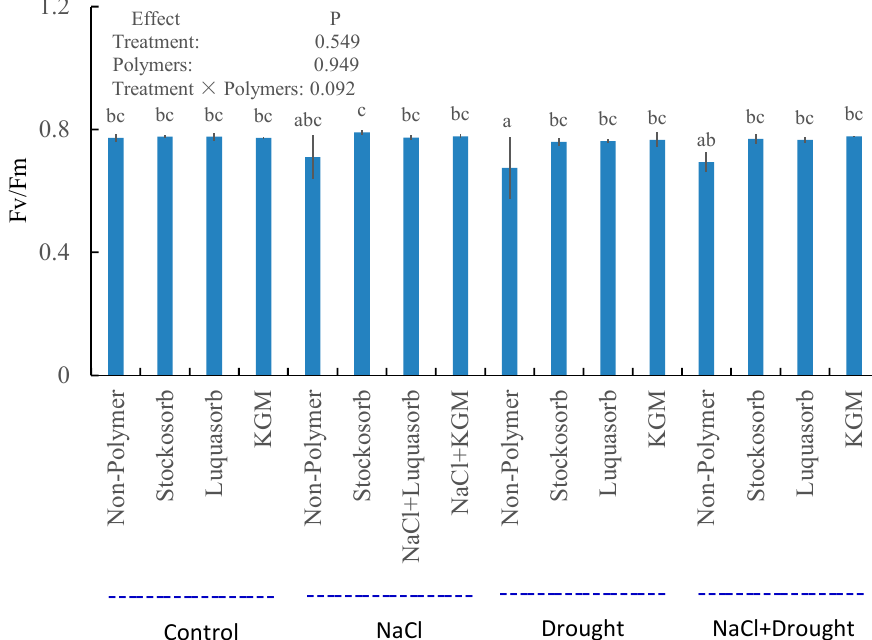
Figure 6. Effect of drought and salt stress on the maximum photochemical efficiency of photosystem II in Metasequoia glyptostroboides seedlings amended with synthetic (Stockosorb, Luquasorb) and natural (Konjac glucomannan, KGM) hydrophilic polymers along with those not amended (Non-Polymer). Chlorophyll a fluorescence was measured on a weekly basis. Each column represents the mean value for three to five individual plants and bars represent the standard error of the mean. Columns labelled with different letters (a, b, and c) are significantly different at the p < 0.05 level.